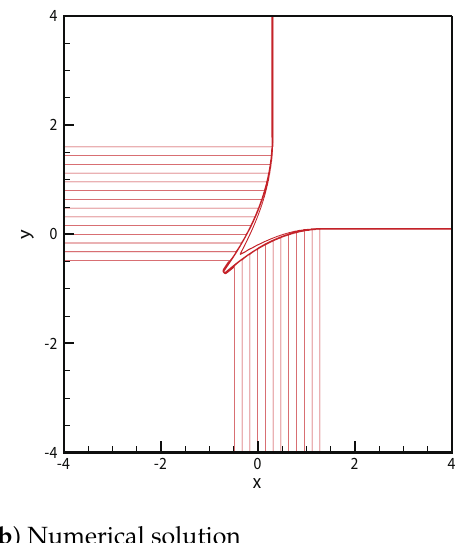
Figure 4. Case 4. S δ + R + R + S δ